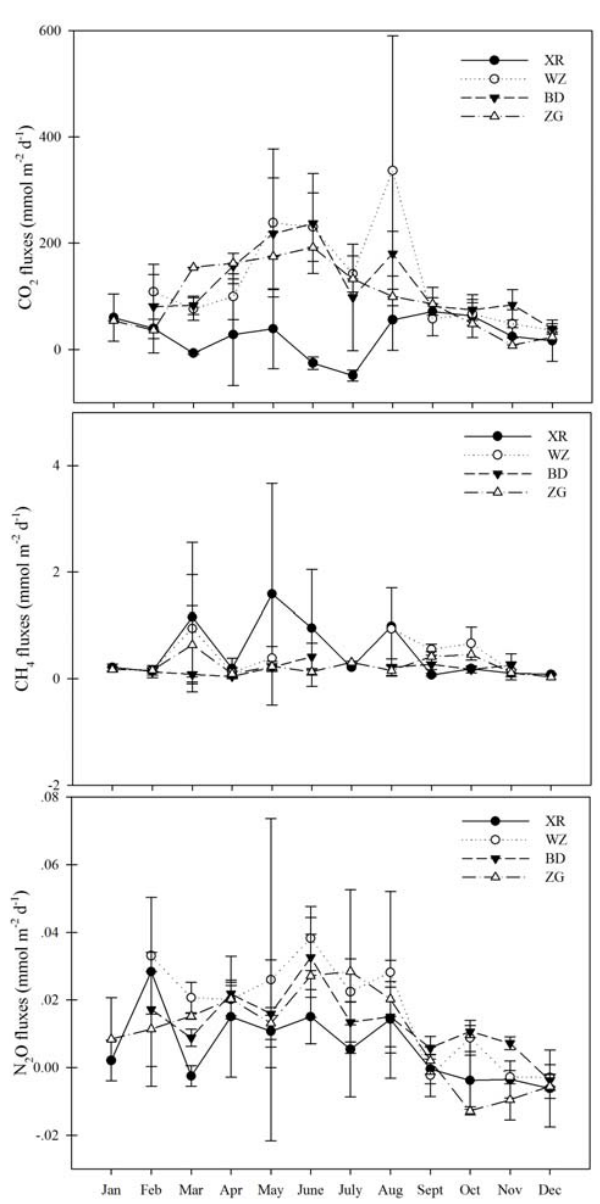
Fig. 3. Seasonal variations of GHG fluxes from three mainstream Figure 3. Seasonal variations of GHG fluxes from three mainstream sites (WZ, BD, ZG) 604 sites (WZ, BD, ZG) and a tributary of XR. The error bars indicate the standard deviations among the replicates at each site in each month. All designations are the same as those in Fig. and a tributary of XR. The error bars indicated the standard deviations among the replicates 605 at each site in each month. All designations are the same as those in Figure 1. 606